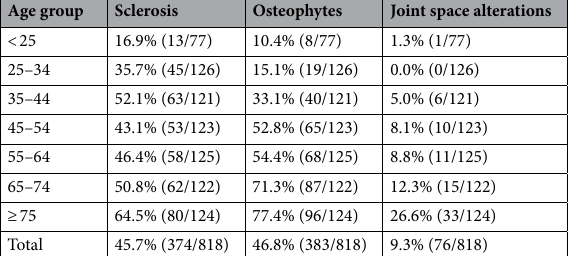
Age group Sclerosis